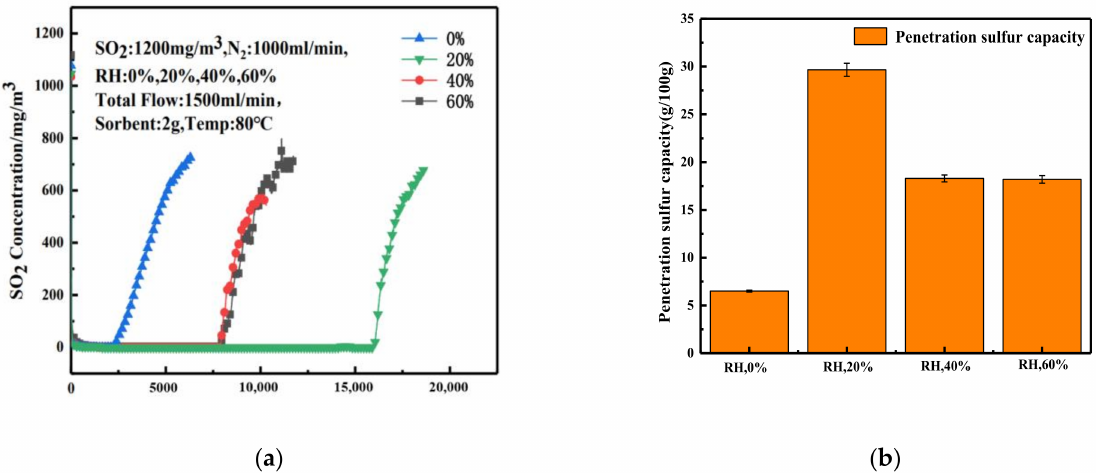
Figure 8. Effect of relative humidity on ( a ) the desulfurization performance and ( b ) penetration sulfur capacity of desulfurization